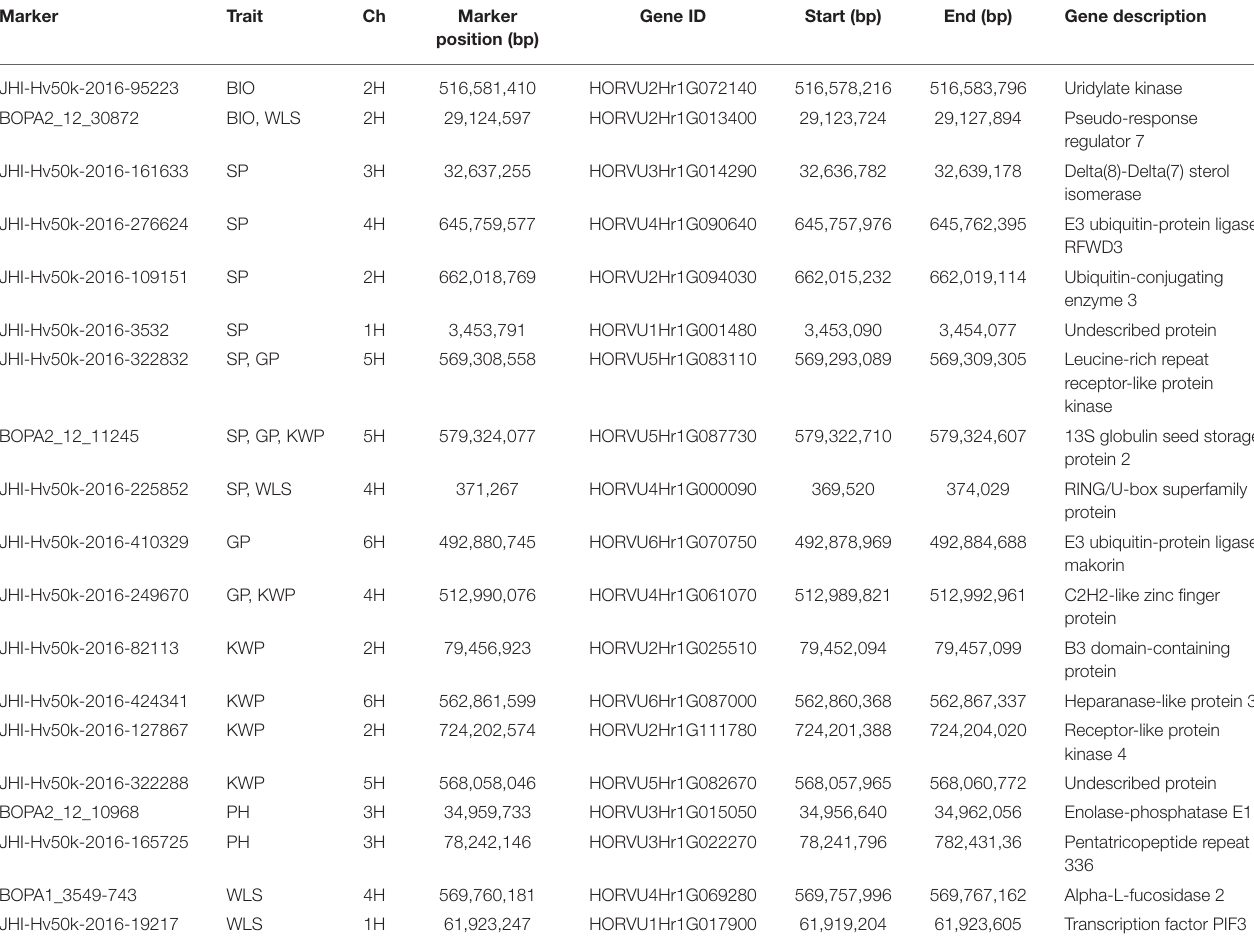
TABLE 7 | Summary of potential candidate genes that contain significant markers associated with the assessed traits under waterlogging treatment conditions. Marker